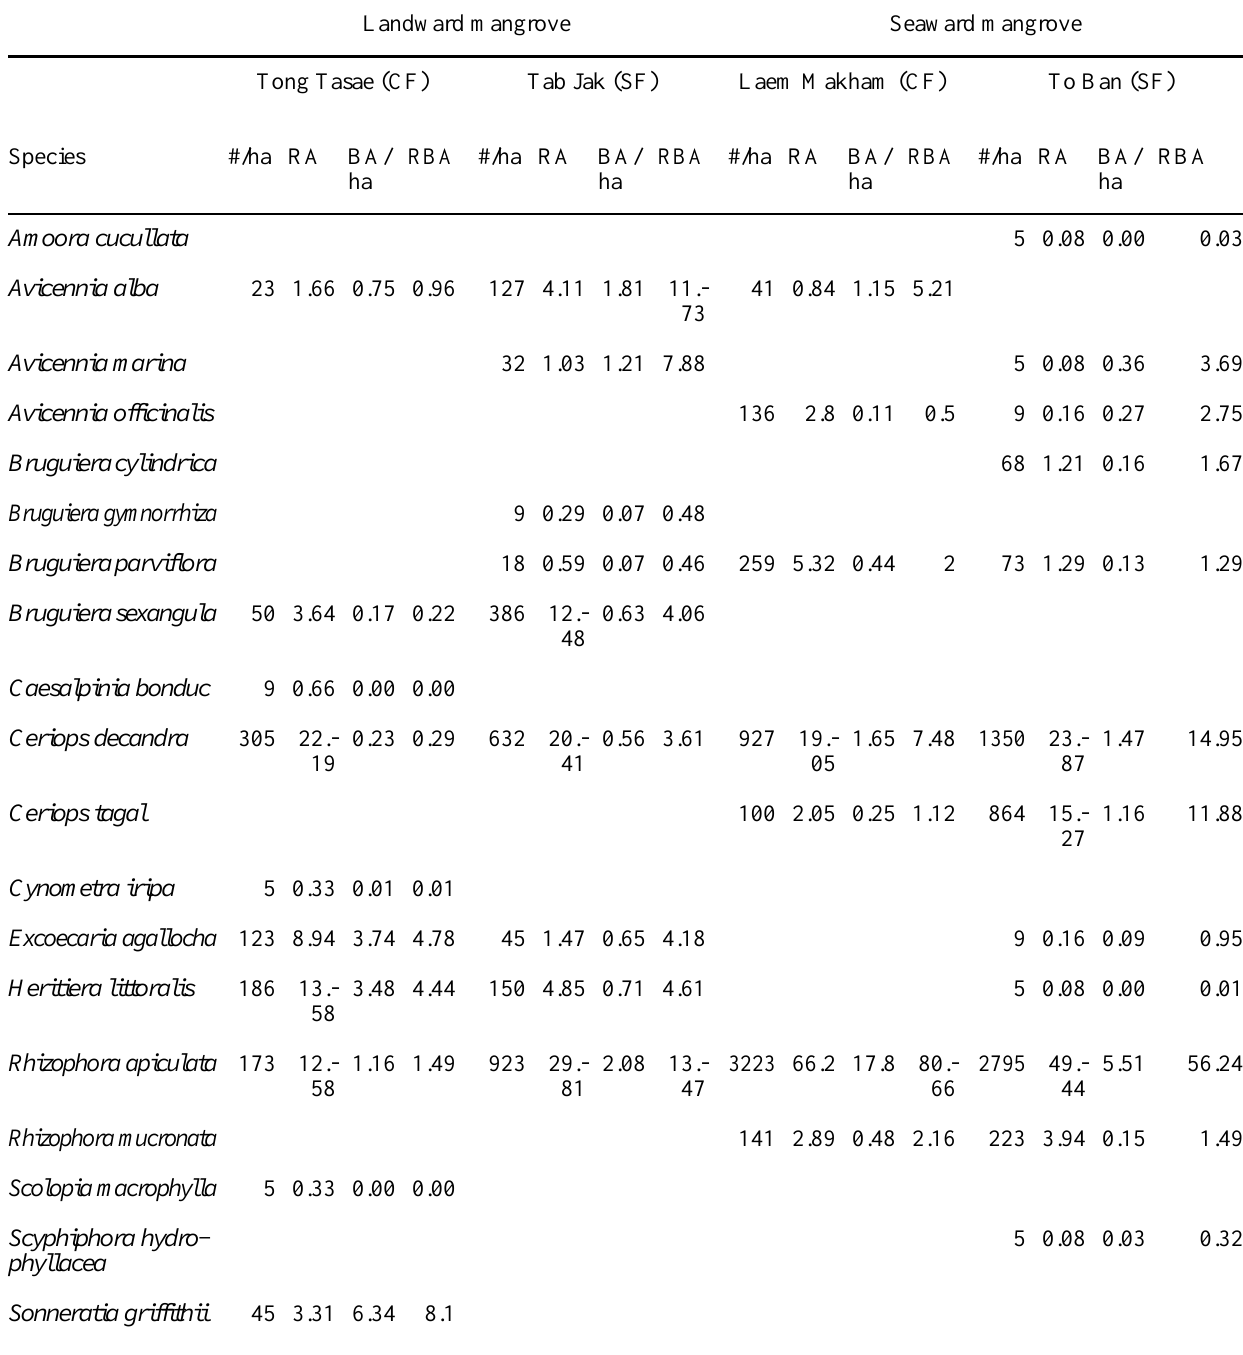
Table 3. Species composition and structural features of all stems ‡ 1.27 cm dbh in four mangrove forests in Trang, southern Thailand. CF: community forest, SF: state forest. #/ha: number of trees per hectare, RA: relative abundance, BA/ha: basal area per hectare (m 2 ), RBA: relative basal area. Species that were present but with a BA or RBA of less than 0.01 are listed as